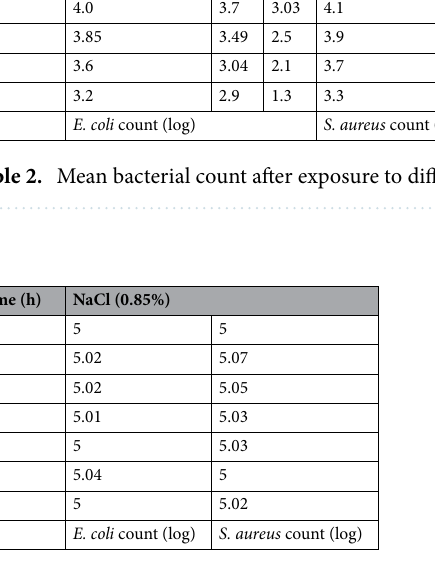
Table 3. Bacterial count (log cfu/cm 2 ) after exposure to saline solution (negative control).